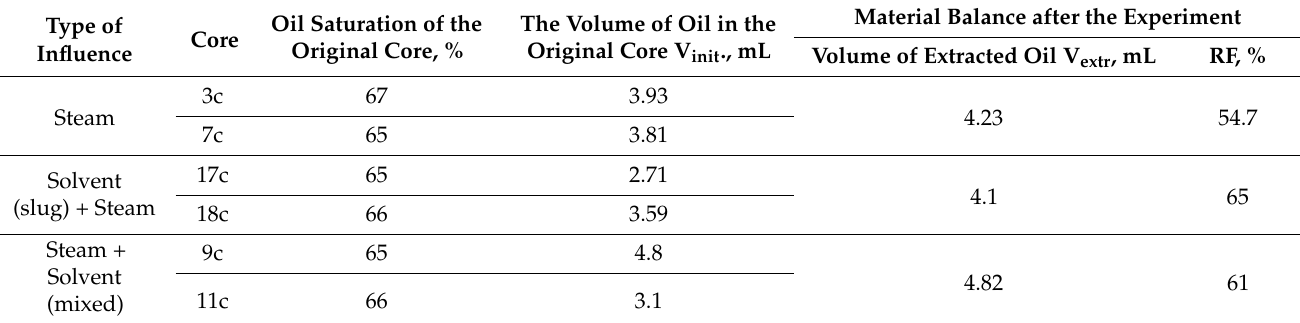
Figure 7. Temperature profiles in the experiment with steam and solvent supplied in a slug.